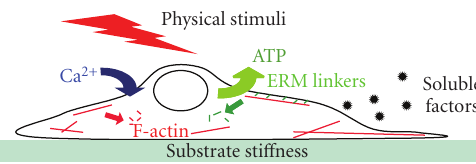
Figure 5: Schematic for an integrative model that depicts coupling mechanisms mediating the e ff ects of physicochemical cues. In addi- tion to e ff ects induced by the soluble factors, an external physical stimulus induces an increase in the cytosolic calcium concentration, which depolymerizes the F-actins and decrease the cell elasticity. The physical stimuli can also cause depletion of intracellular ATP, for example, by ATP release that, in turn, leads to inhibition of the ERM protein linkers’ binding properties and their dissociation from the membrane and actin cytoskeleton. A separation of the cell membrane from the cytoskeleton occurs and e ff ectively decreases the membrane tension, attributable both to down-regulation of active ERM proteins and actin depolymerization. Altered calcium dynamics along with cytoskeletal remodeling may not simply be consequences of stem cell di ff erentiation but rather important key factors regulating